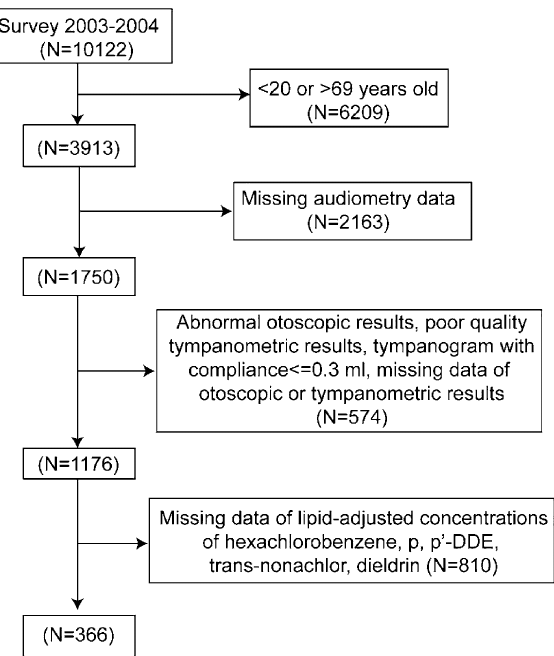
Figure 1. Flow chart of participant selection. Abbreviations: p, p’-DDE, p,